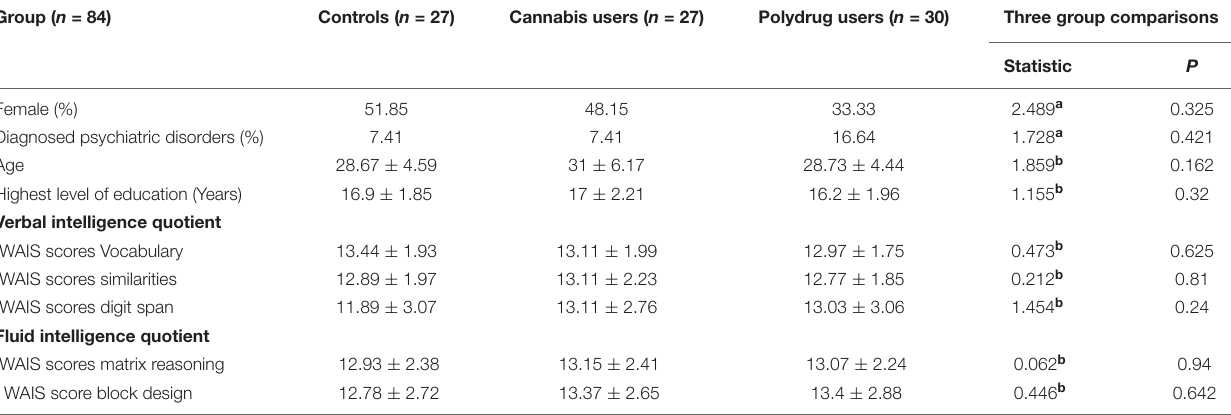
TABLE 1 | Demographic and intelligence characteristics of the